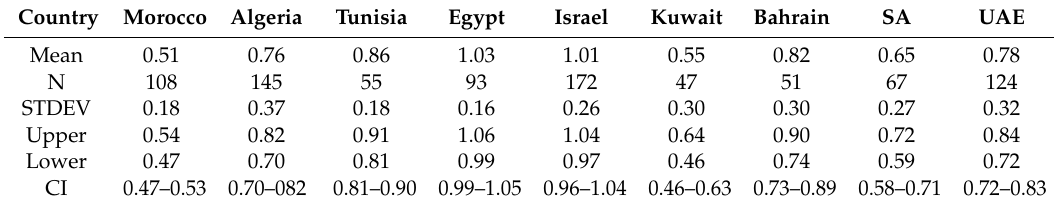
Table 3. Detailed information of Ångström exponent in Figure